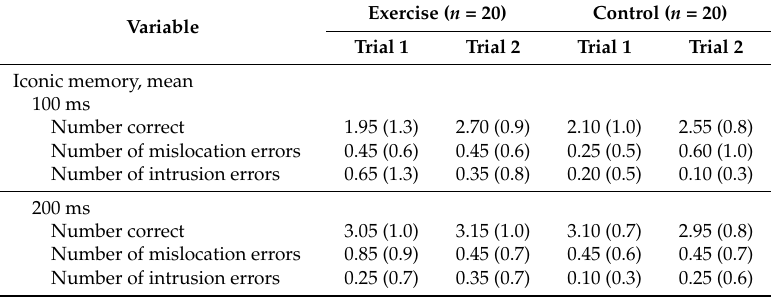
Table 2. Memory scores (iconic memory, mean) across the experimental and control